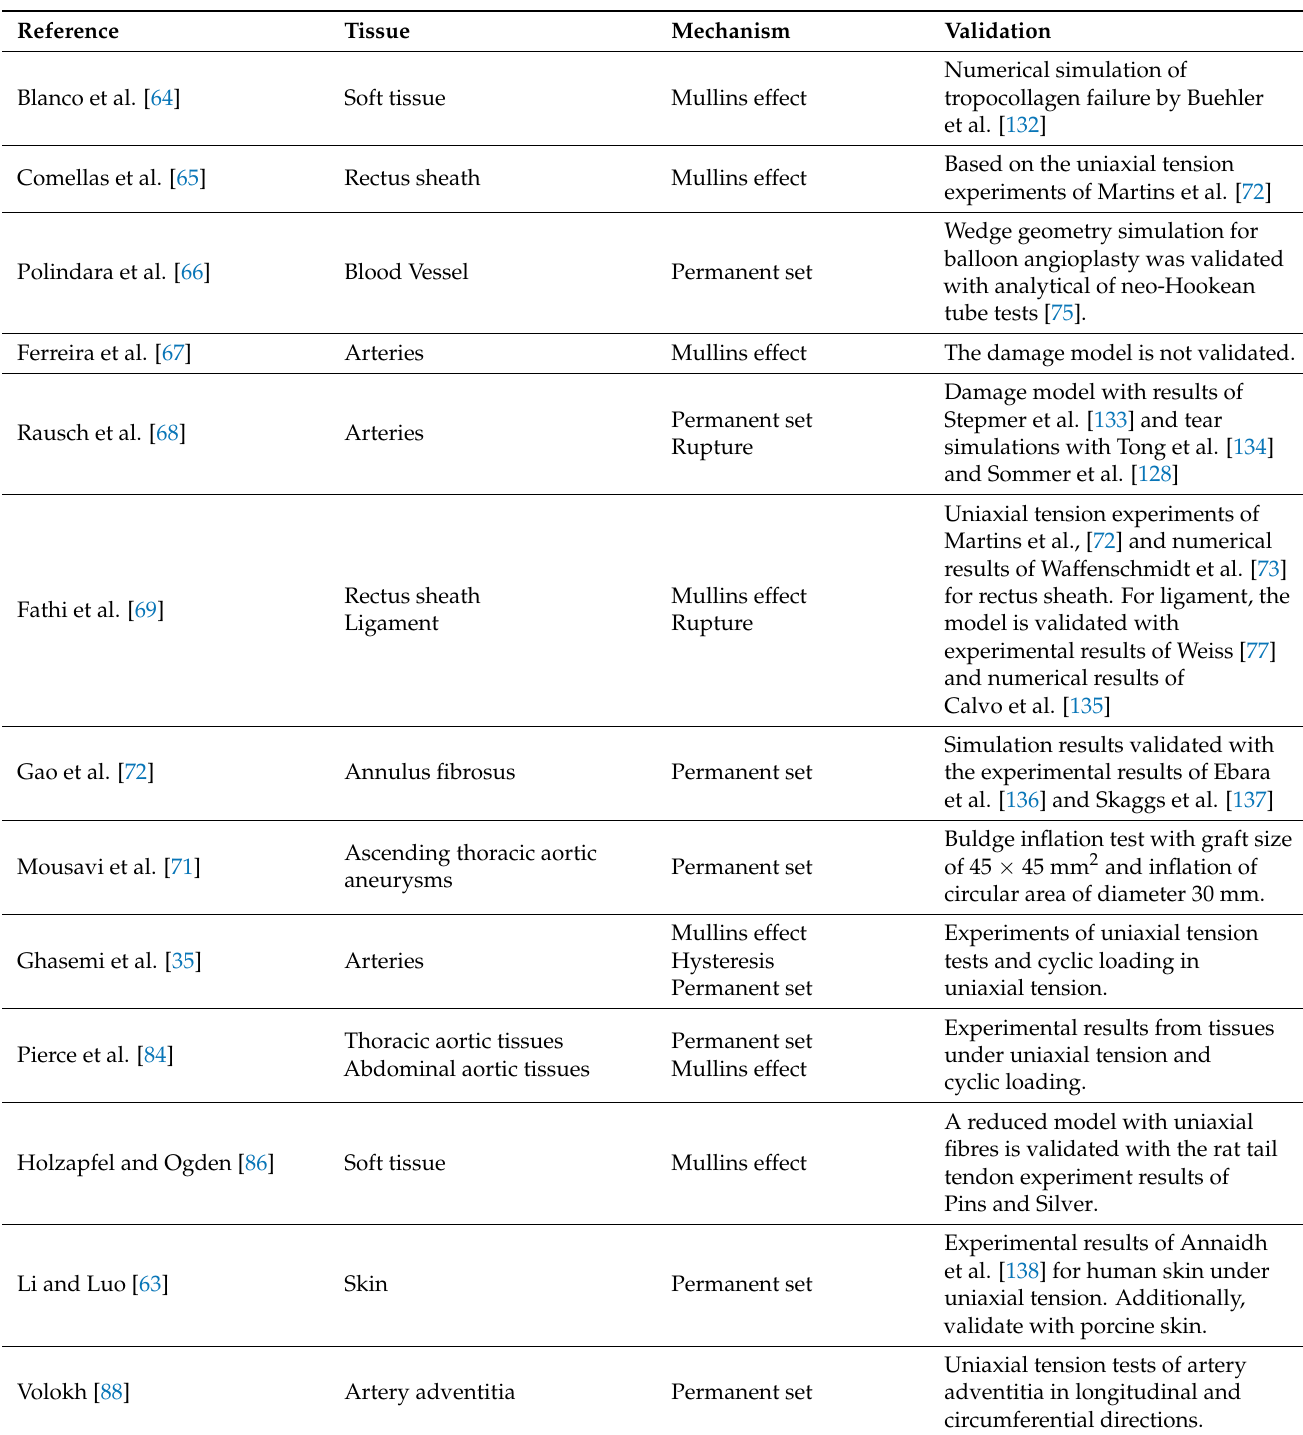
Table 4. Damage models applied to tissues and their validation